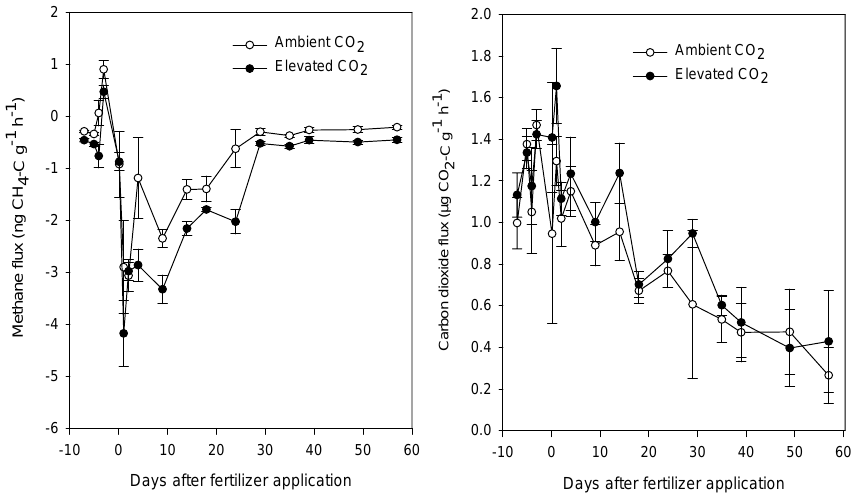
Fig. 1. Daily fluxes of CH 4 ( ŋ g CH 4 –C g ‐ 1 h ‐ 1 ) and CO 2 (µg CO 2 ‐ g ‐ 1 h ‐ 1 ) (Avg. ±SD) from temperate grassland soil exposed to elevated CO 2 and soil without elevated CO 2 treatment i.e. ambient incubated under controlled laboratory conditions following the application of NH 415 NO 3 and 15 NH 4 NO 3